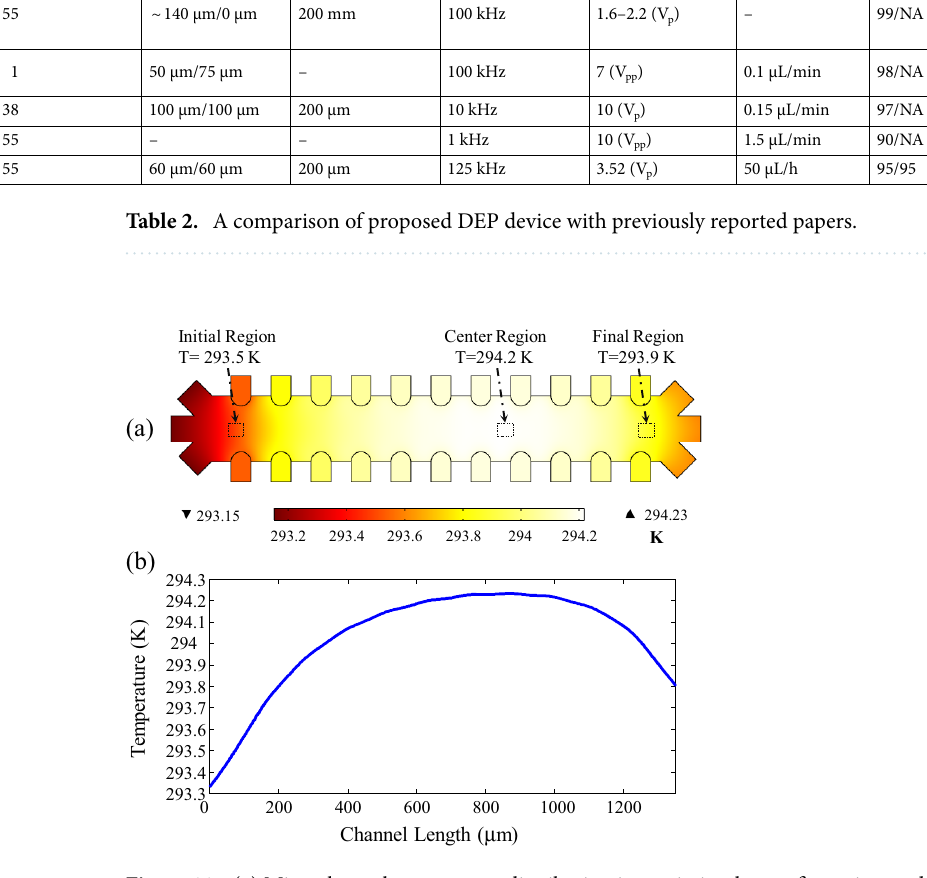
Figure 11. ( a ) Microchannel temperature distribution in semi-circular configuration under the voltage amplitude of 3.52 V and flow rate of 50 μL/h. ( b ) Temperature profile on the